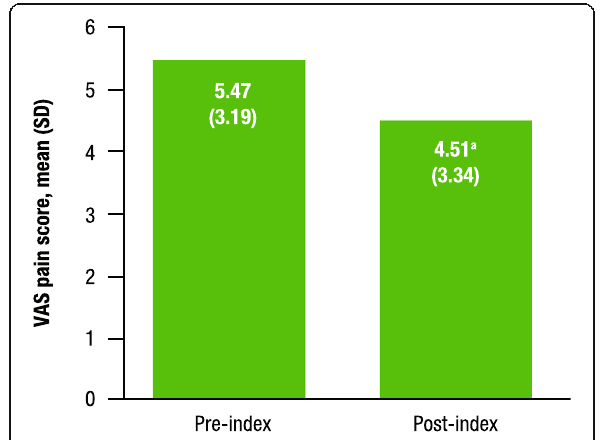
Fig. 2 Change in the MPI VAS for headache. MPI, migraine pain intensity; VAS, visual analog scale; SD, standard deviation. a P =0.014 for pre-index vs.